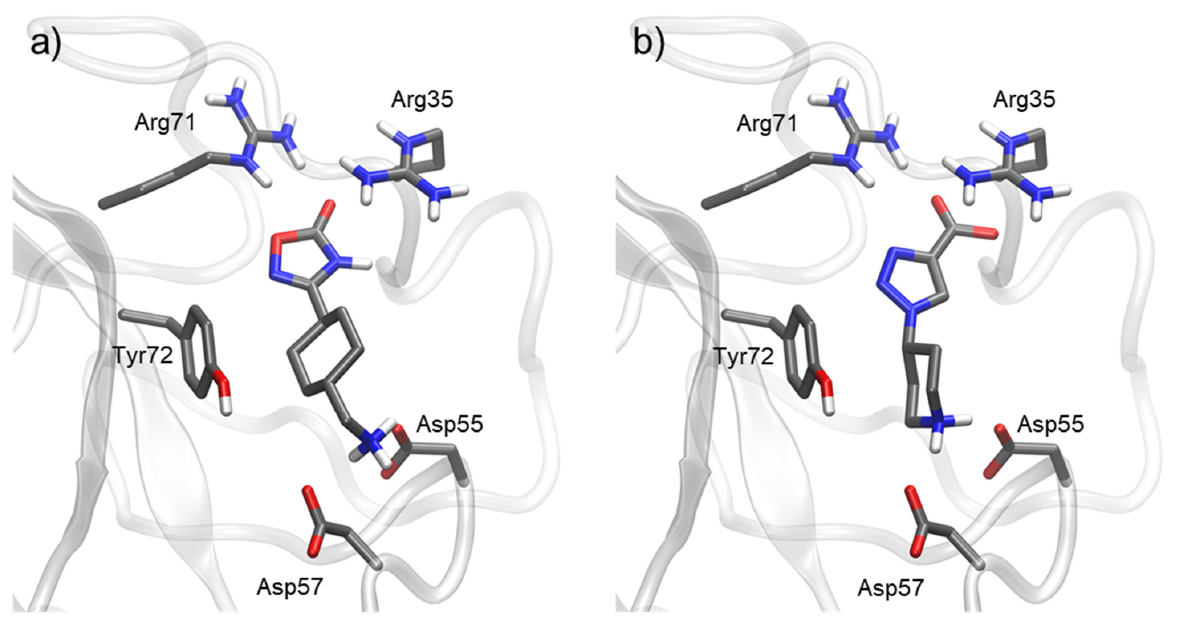
Figure 6. Docking of most representative poses for compounds 11 ( a ) and 8 ( b ). Docking studies were performed with Kringle 1 lysine binding site (pdb code 1cea) using AutoDock 4.2. The docking poses for compounds 9 and 10 (Figure 7) were very similar to those of 1 and 5 . The interactions of the piperidine moiety, as well as the oxadiazolone ring, with the lysine binding site were maintained. For the triazole ring region, the change in structure from a 1,2,3-triazole to a 1,2,4-triazole did not eliminate the pi–pi stacking interaction with Tyr72. Therefore, docking itself was insufficient to explain the loss of activity of compounds 9 and 10 with respect to 1 and 5 . Molecular dynamics analysis was performed to assess whether the change in the triazole ring in compound 9 could affect the dynamics of the ligand in the lysine binding site.